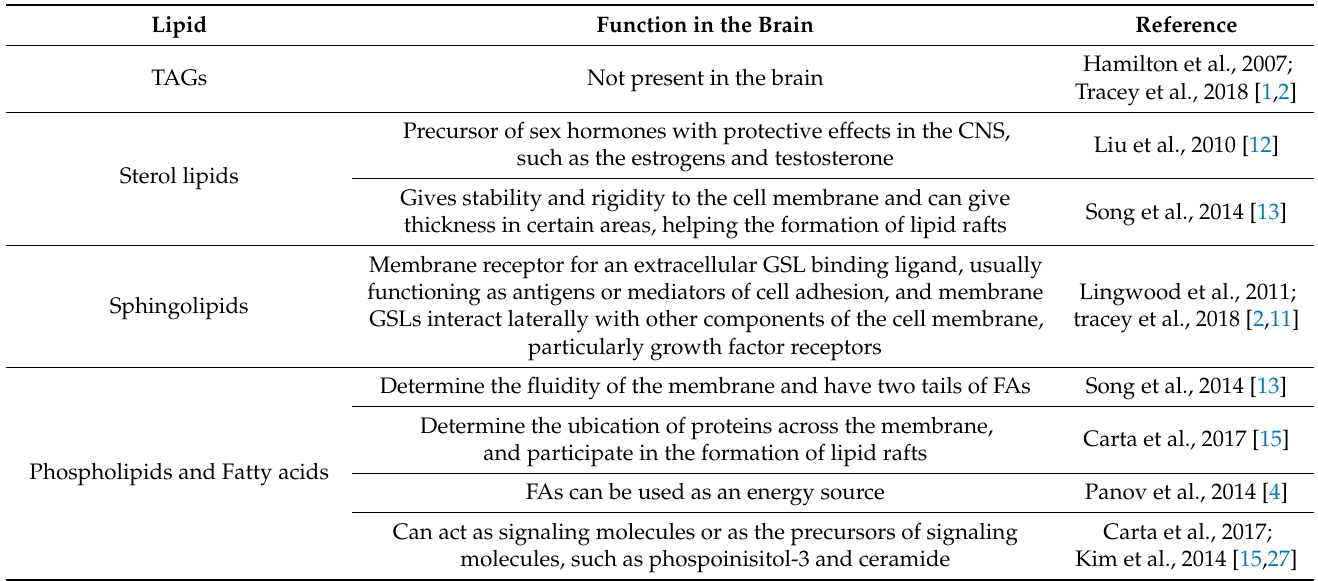
Table 1. The role of the different lipids in the brain. A summary list of five of the most common lipid types in biological organisms, triacylglycerols (TAGs), sterol lipids, sphingolipids, phospholipids, and fatty acids, and their functions in the